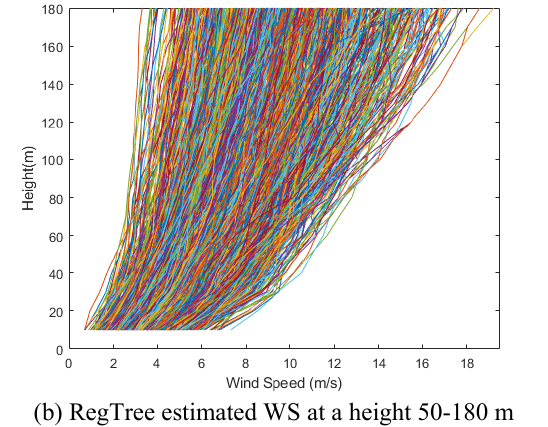
(a) RELM estimated WS at heights 50-180 m (b) RegTree estimated WS at a height 50-180 m